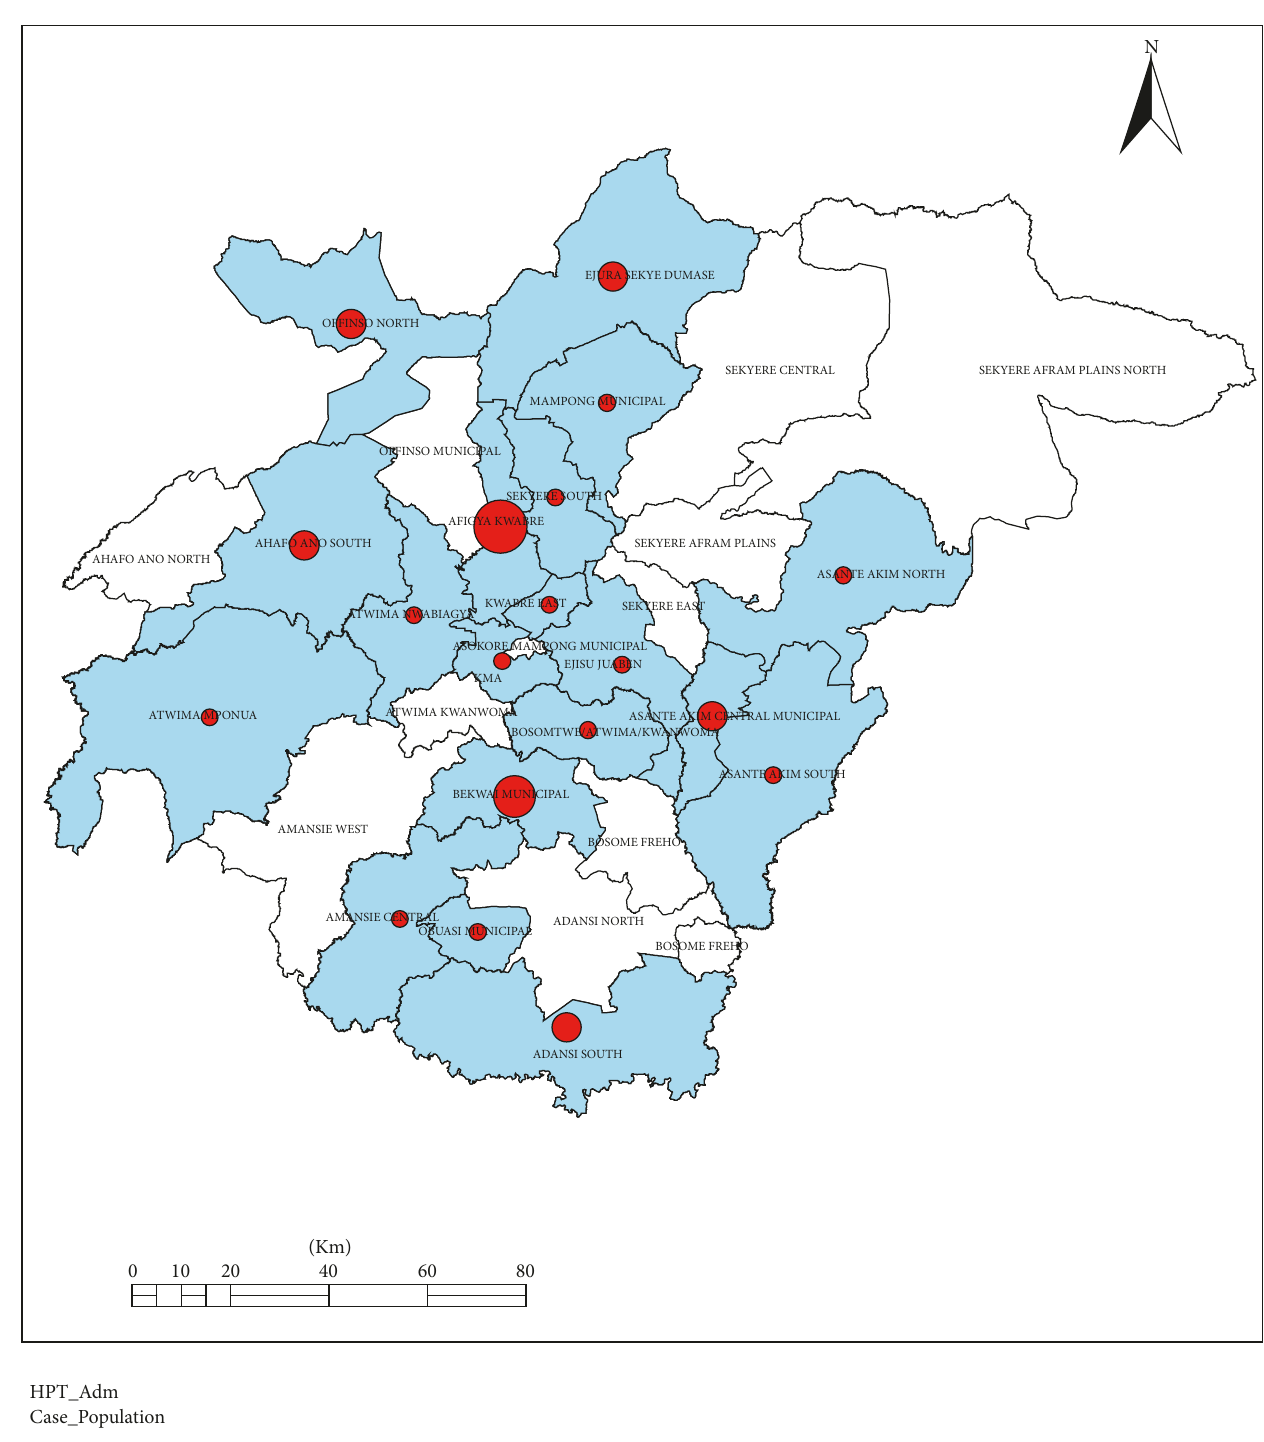
Figure 2: Case density of hypertension admission as reported by hospital, Ashanti,